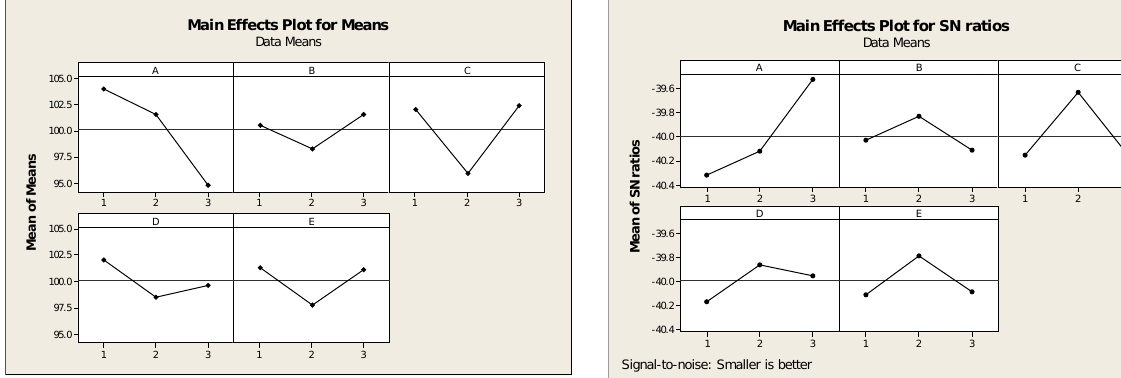
Fig. 3. Main Effects Plot for Means Fig. 4. Main Effects Plot for SN ratios